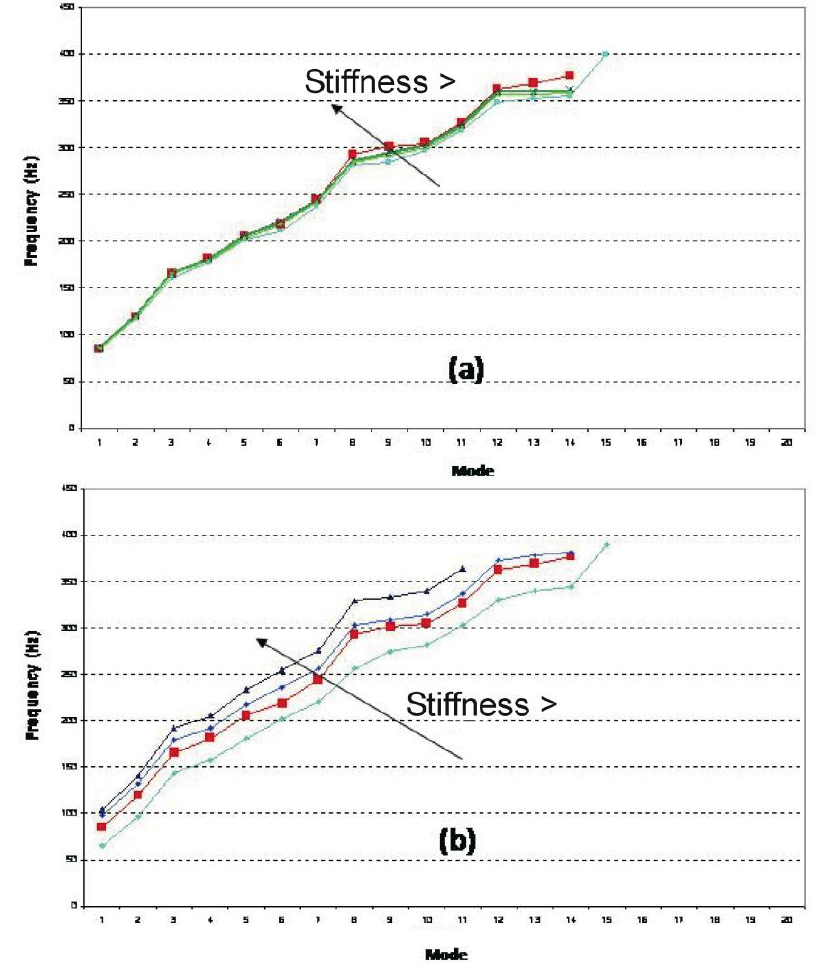
Figure 9. ( a ) Metal Sheet plus Lightweight Multilayer Composite: Adhesive Stiffness Analysis;